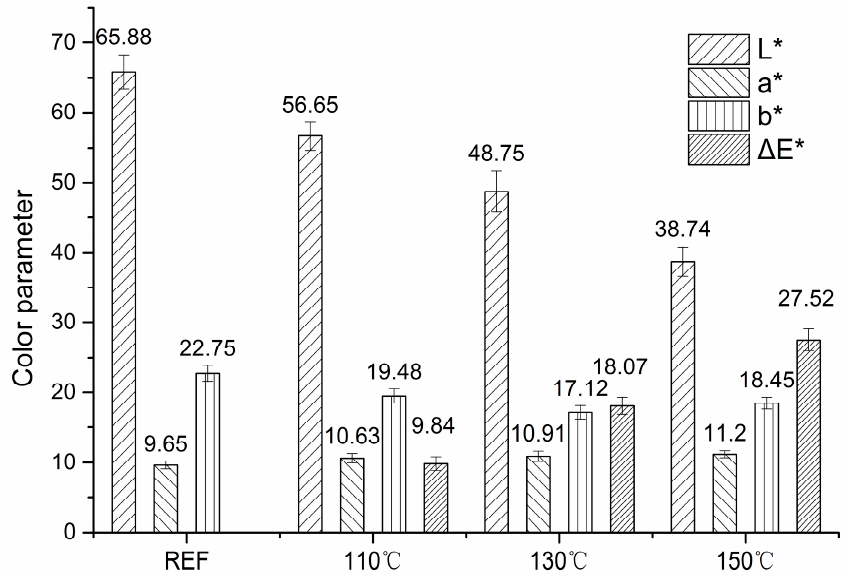
Figure 1. Comparative color parameter analyses under saturated steam.